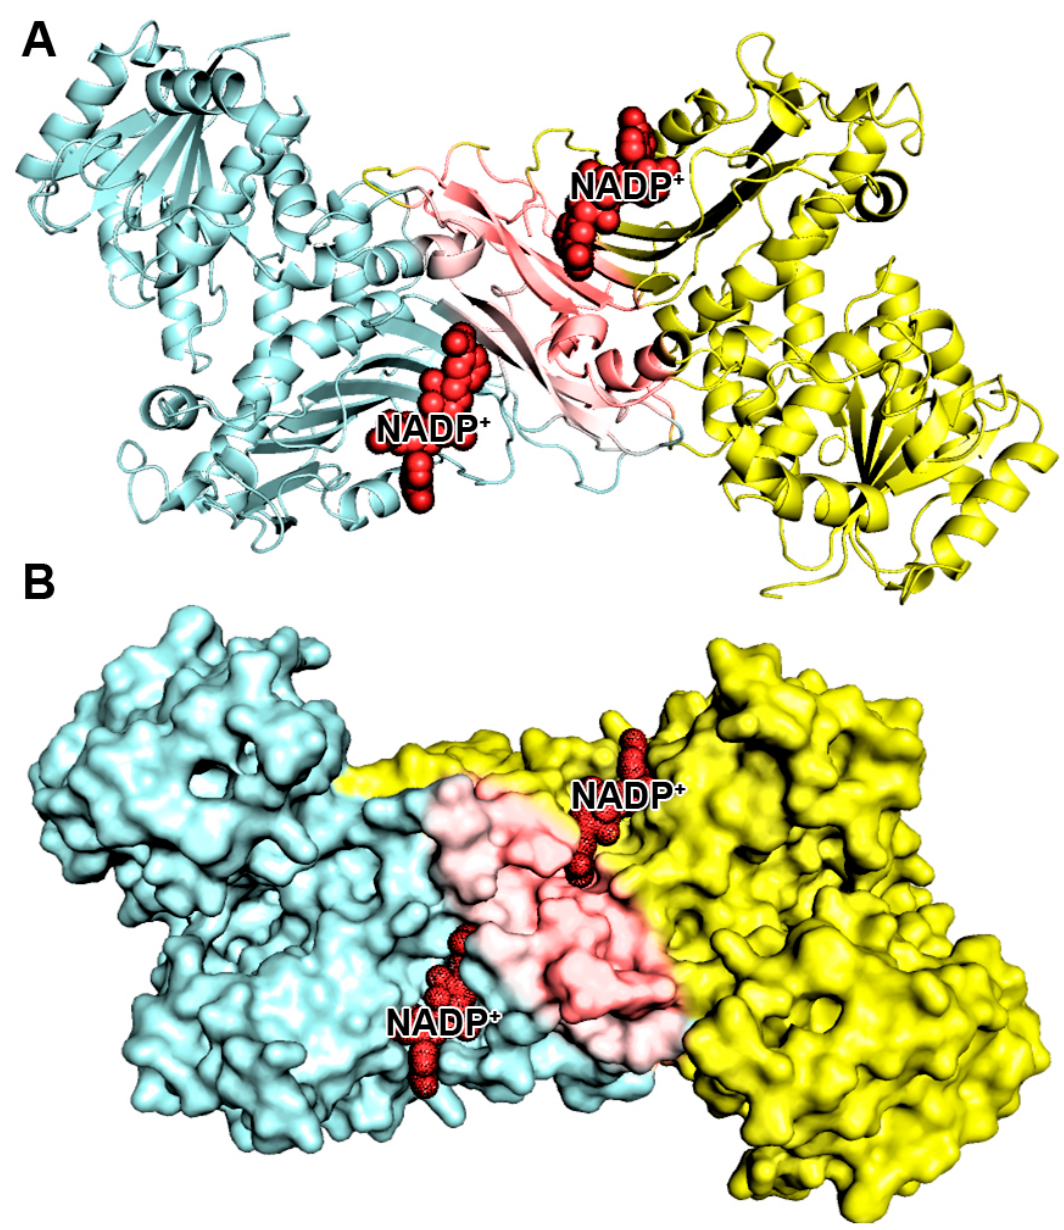
Figure 1. Depiction of the target enzyme G6PD and its active sites. ( A ) the target enzyme G6PD-dimer represented as a cartoon model; ( B ) the target enzyme G6PD-dimer represented as a surface model. Monomer-1 (cyan color) and monomer-2 (yellow color) are connected and formed dimer formation dimer interface active site (pink color), dark red color spheres designate the NADP + binding sites. The dimer interface is designated with red.